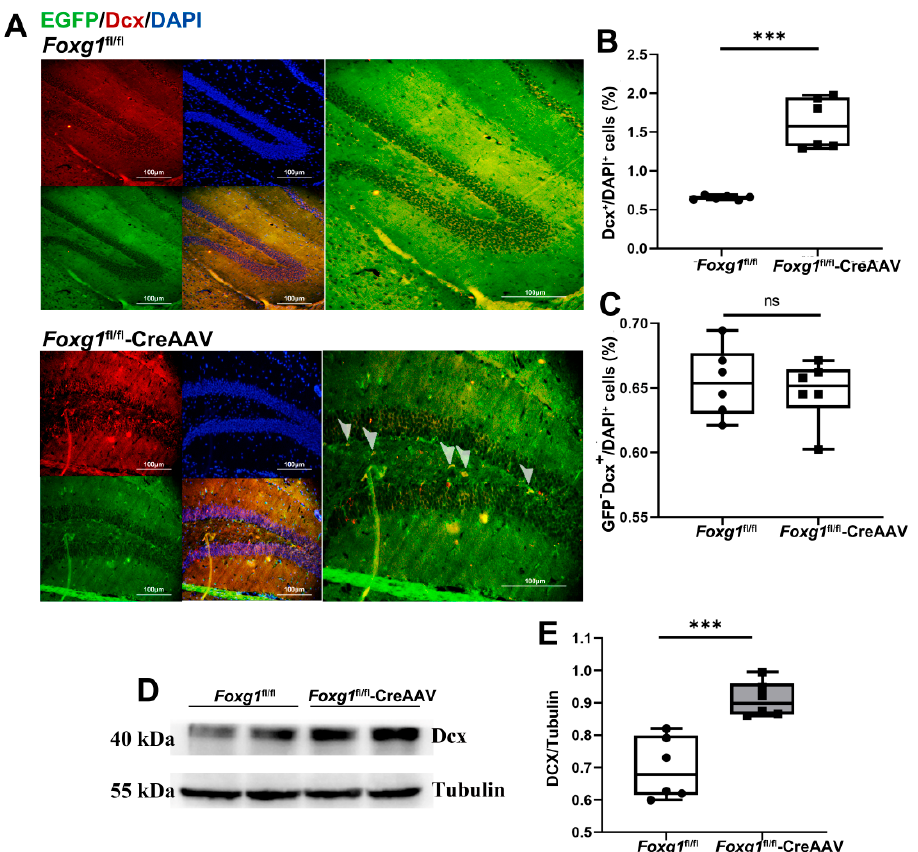
Figure 5. FOXG1 increases the amount of doublecortin (Dcx)-expressing newborn neuroblasts in adult hippocampal DG of the Foxg1 genotype mice. ( A ) Expression patterns of Dcx-expressing neuroblasts in the hippocampal DG of Foxg1 genotype mice were assessed with immunofluorescence. Red = Dcx; Green = EGFP-labeled FOXG1; Blue = DAPI. Scale bars = 100 μ m. Arrow heads: newly generated neuroblasts with FOXG1 activation. ( B ) Levels of total neuroblasts in adult hippocampus are showed as %Dcx + /DAPI + cells. ( C ) Levels of endogenous neuroblasts in adult hippocampus are showed as %GFP - Dcx + /DAPI + cells. ( D , E ) Hippocampal lysates of the two genotype mice were immunoblotted using an antibody against Dcx. Values are expressed as means ± S. E. M. n = 6/group. Significant levels set at *** p < 0.001 noted difference between Foxg1 fl/fl and Foxg1 fl/fl -CreAAV animals. ns—not significant.